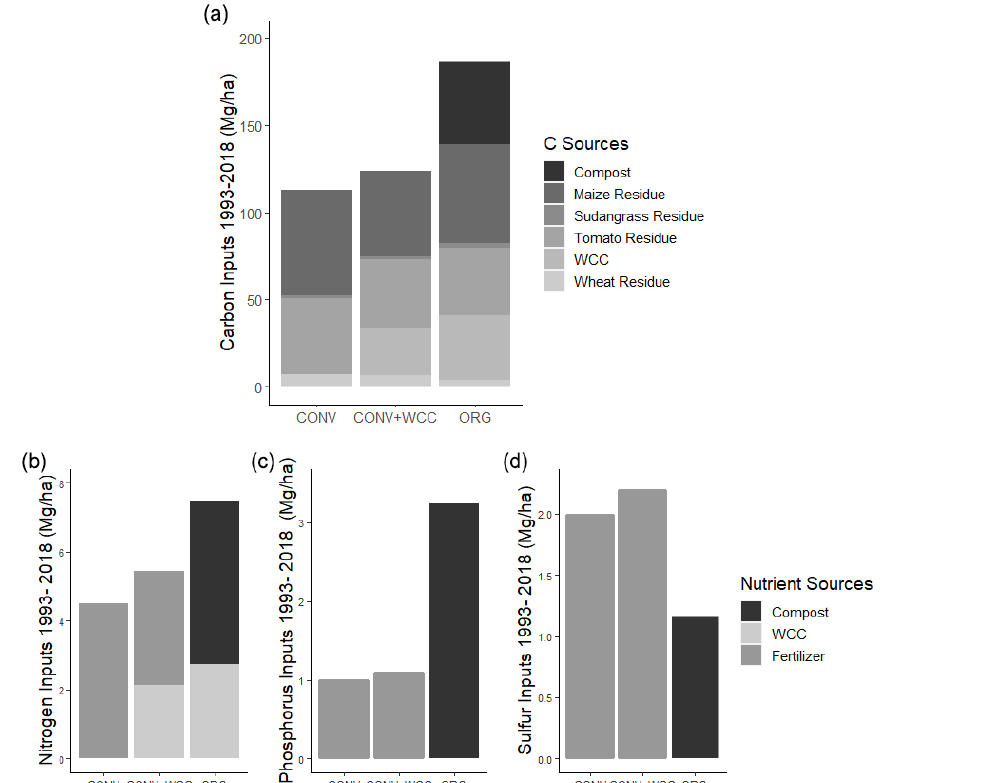
Figure 1. (a–d) Total aboveground C, N, phosphorus, and sulfur added per plot to ORG, CONV + WCC, and CONV systems between 1993 and 2018. All values are given on a mass basis (megagram per hectare).